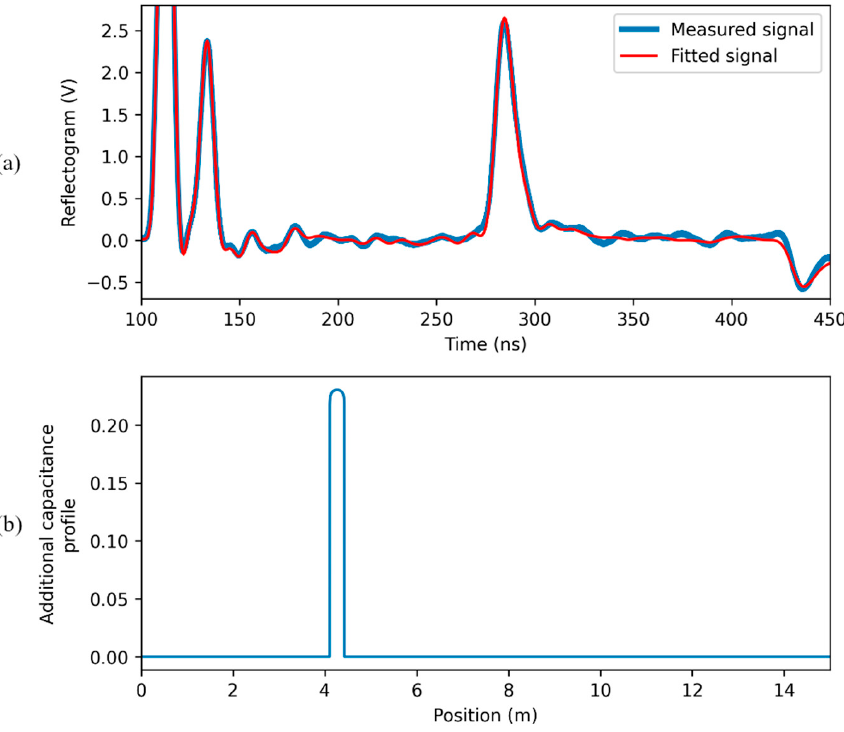
Figure 11. Results of the measurement phase for the reflectogram of Figure 8: ( a ) measured and fitting signal; ( b ) estimated additional capacitance